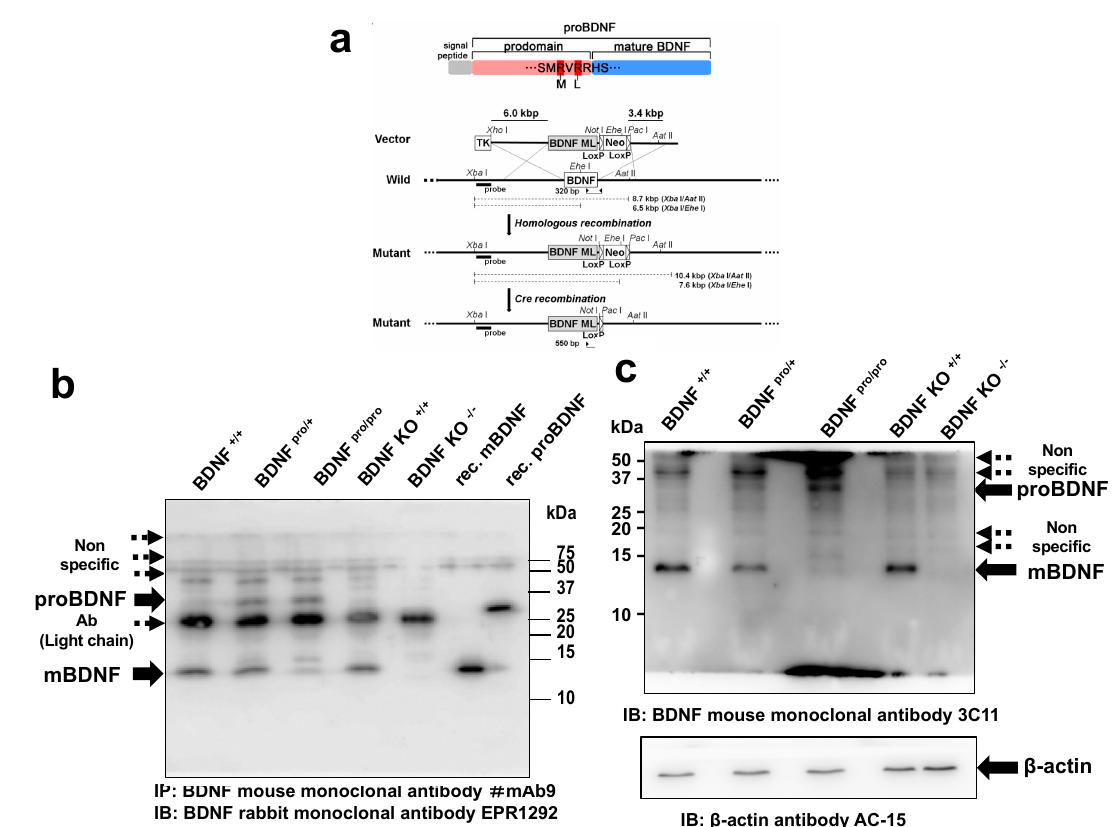
Figure 1. Generation of a knock-in mouse line expressing low levels of mature brain-derived neurotrophic factor (mBDNF). ( a ) Strategy used to replace the coding region of Bdnf with cDNA encoding cleavage-resistant proBDNF. (Top) The cleavage-resistant form of BDNF contains two amino acid substitutions proximal to the cleavage site of proBDNF. (Bottom) The wild-type allele yields an 8.7-kb fragment, and the mutant allele yields a 10.4-kb fragment with XbaI / AatII digestion of genomic DNA. XbaI / EheI digestion results in a 6.5-kb fragment in the wild type and a 7.6-kb fragment in the mutant. Broken lines in the upper schema indicate the approximate locations of these four fragments. ( b ) Western blot showing the influence of amino acid substitutions (R → M, R → L in panel a) proximal to the cleavage site of proBDNF on the expression of proBDNF and mature BDNF. Hippocampal lysates (containing 500 µ g protein) were incubated with a mouse monoclonal antibody (clone; mAb#9) recognizing both proBDNF and mature BDNF [32], and Western blotting was performed with a rabbit anti-pan-BDNF monoclonal antibody (clone; EPR1292; Abcam); BDNF +/+ , BDNF pro /+ , BDNF pro / pro mice were 8 weeks old, and BDNF KO +/+ BDNF KO − / − mice were 2 weeks old. ( c ) Immunoblot analysis of mBDNF and proBDNF in hippocampal lysate (25 µ g protein / lane). BDNF +/+ , BDNF pro /+ , BDNF pro / pro mice were 8 weeks old, and BDNF KO +/+ BDNF KO − / − mice were 9 days old. Note that mBDNF and proBDNF were detected with a mouse anti-pan-BDNF monoclonal antibody (clone; 3C11, Icosagen), followed by Wosnitzka et al. (2020) [34]. Membranes have been re- probed with a mouse anti- β -actin monoclonal antibody (clone; AC15, Sigma) to check for an equal amount of protein.